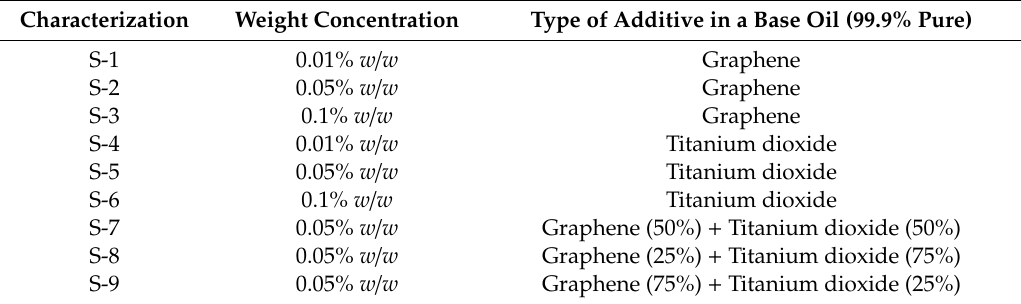
Table 1. Sample characteristics of liquid base lubricants (liquid nano lubricants).